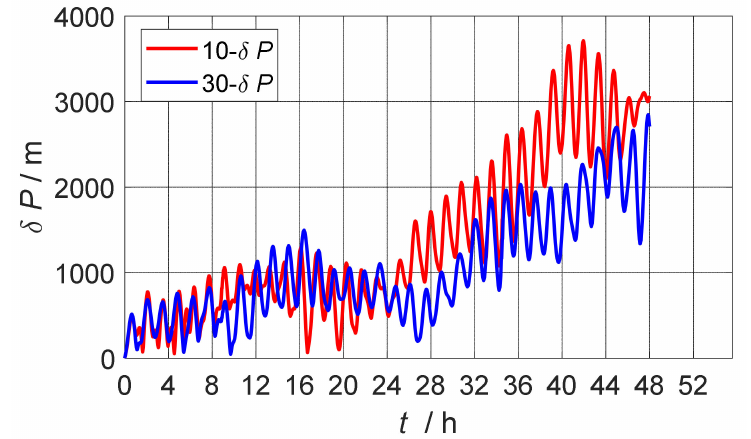
Figure 3. Comparison of positioning error of navigation after calibration compensation of 30-position scheme and 10-position scheme.